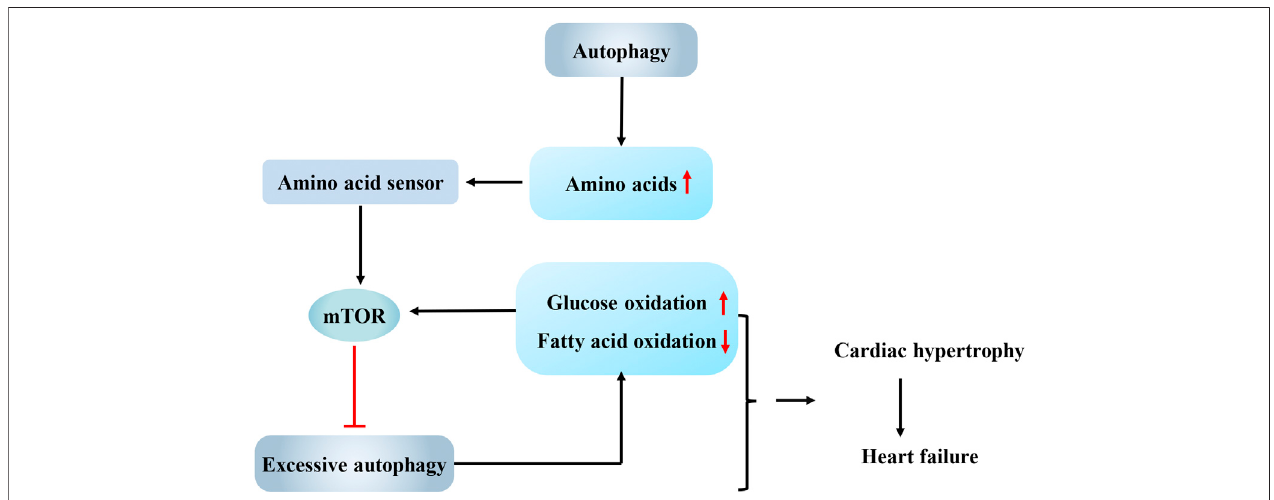
FIGURE 1 | Interaction between autophagy and energy metabolism in cardiac hypertrophy. Autophagy supplies amino acids for protein synthesis in cardiac hypertrophy, while abundant amino acids interact with amino acid sensors to activate mammalian target of rapamycin (mTOR) and avoid excess autophagy activation. Overactivated autophagy leads to a shift in energy metabolism from fatty acid oxidation to glucose oxidation. In turn, the change in the energy substrate can activate mTORandtheninhibitautophagy.Andtheinteractionbetweenthemmaybeoneexplanationfortheobservationthatcardiachypertrophyeventuallyprogressesto heart failure. mTOR, mammalian target of